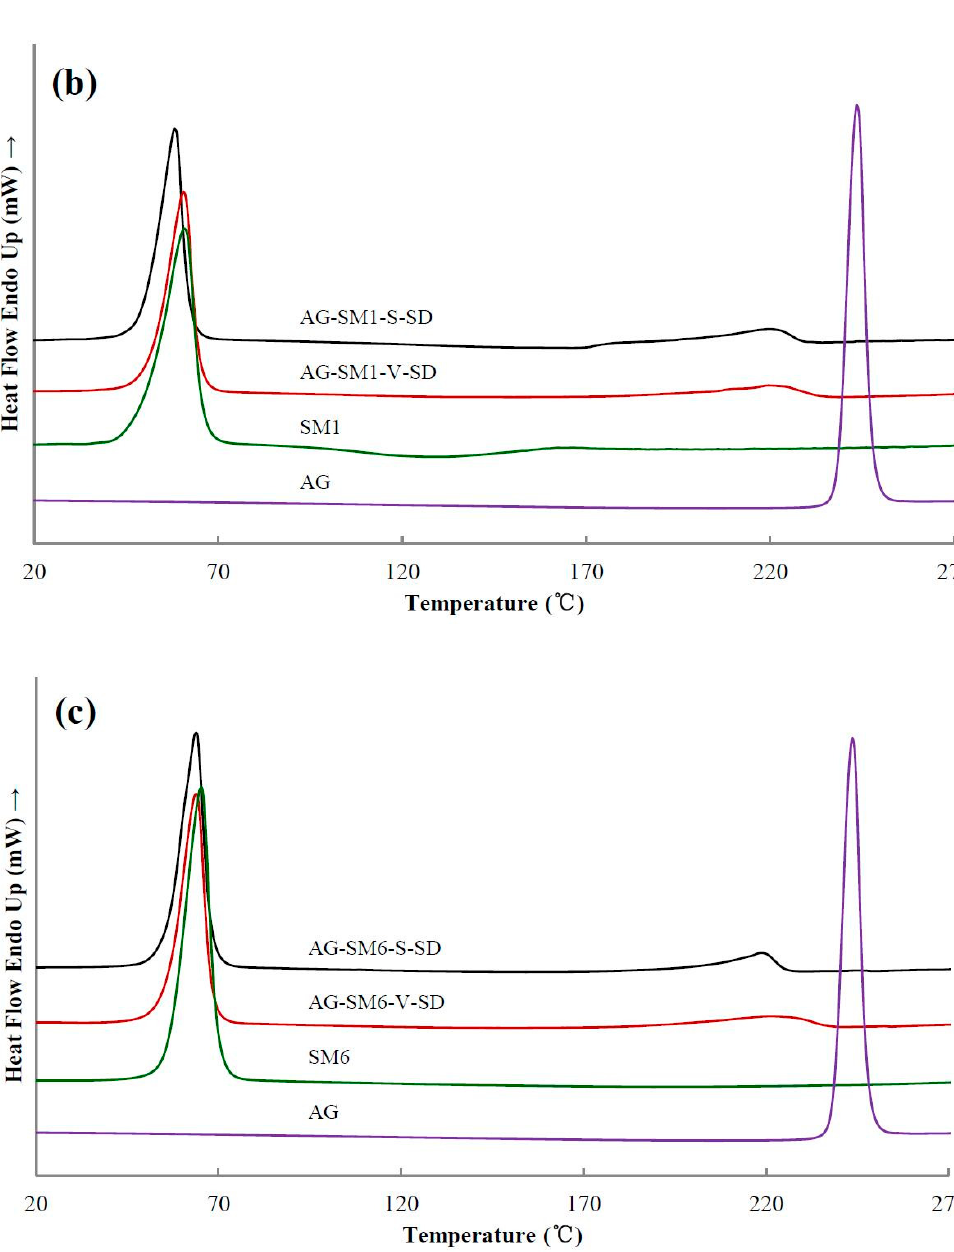
Figure 4. Differential scanning calorimetry (DSC) thermograms of pure andrographolide (AG), carrier materials, and solid dispersions (SD): ( a ) PEG4000 as carrier material, ( b ) SM1 as carrier material, ( c ) SM6 as carrier material.